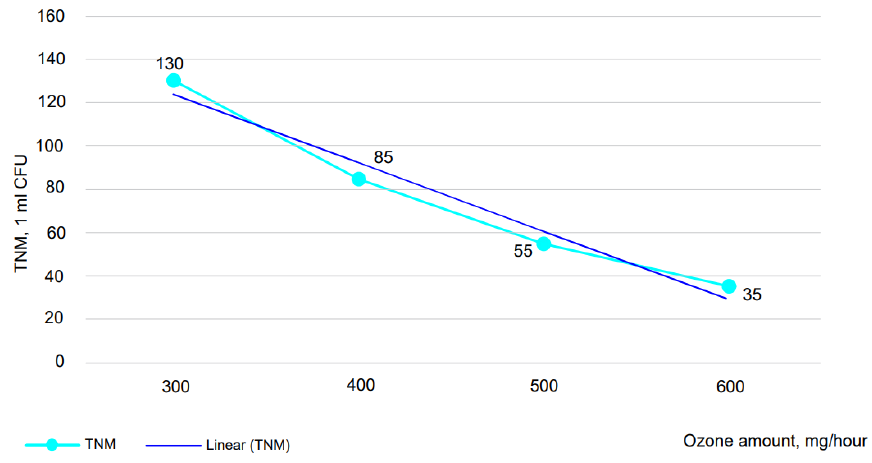
Figure 5. Interactions between the total number of microbes and ozone dependence.